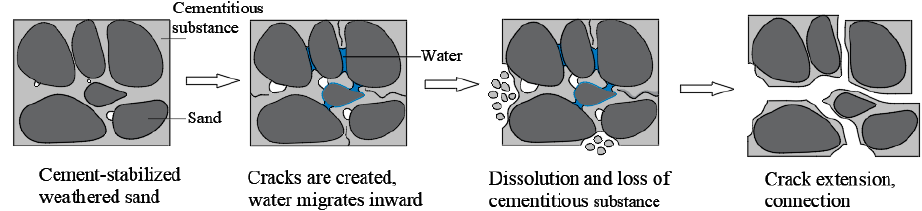
Figure 13. The freeze–thaw deterioration process of cement-stabilized weathered